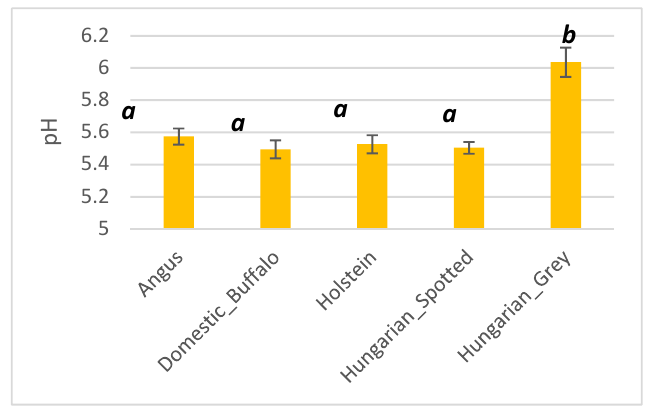
Figure 2. Bar plot showing the pH of Angus, domestic buffalo, Holstein, Hungarian Spotted, and Hungarian Grey bovine breeds. Different superscripts imply significant differences.